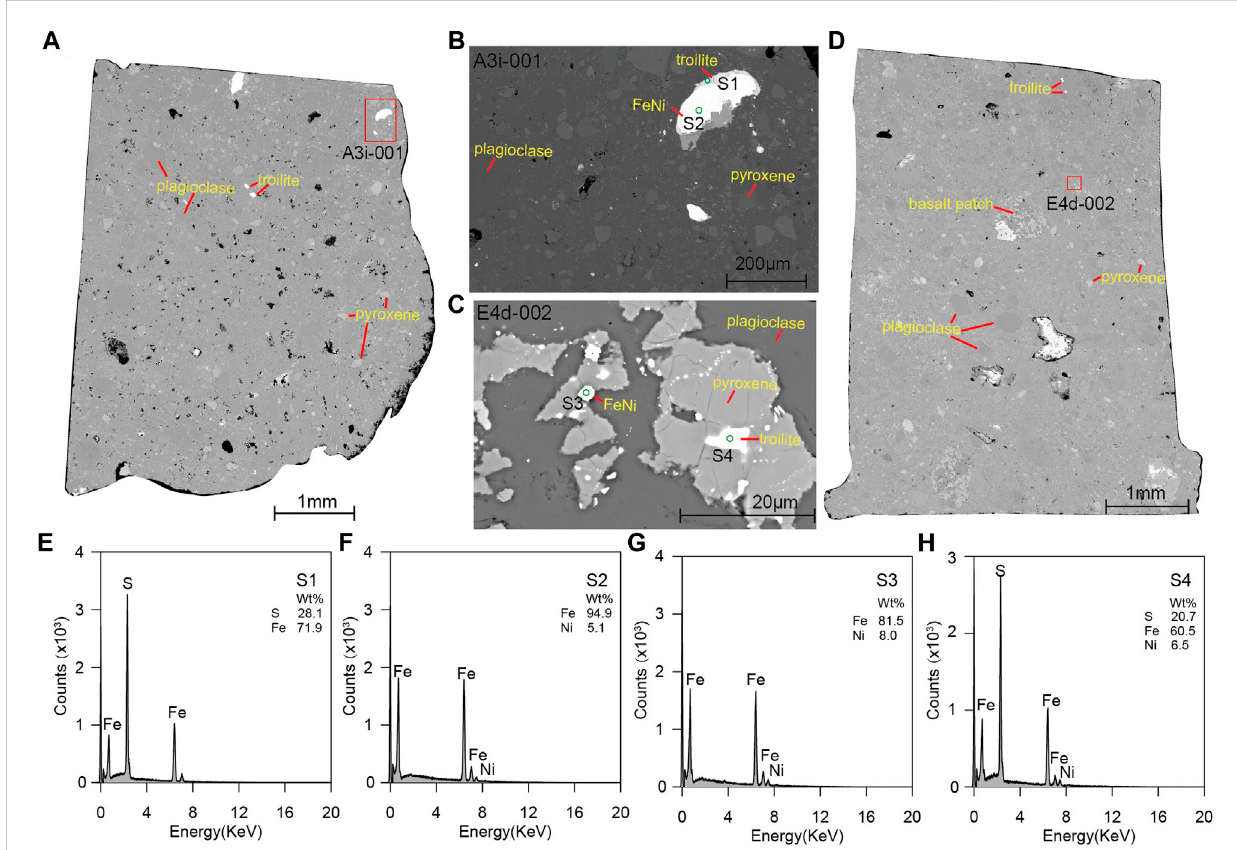
FIGURE 9 (A – D) Representative BSE images of the studied lunar meteorite NWA13788. (E – H) The EDXS results of the studied lunar meteorite NWA13788.